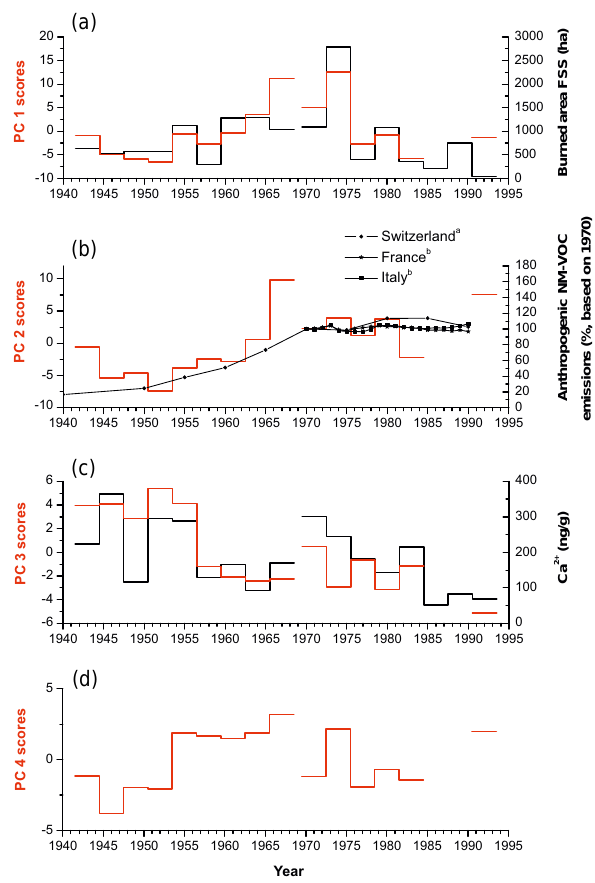
Figure 6. (a) Records of PC1 and FSS (burned area by fires in southern Switzerland), (b) PC2 and anthropogenic emissions of non-methane volatile organic compounds (NM-VOCs) in Switzer- land, France, and Italy from 1940 to 1990, (c) PC3 and his- toric record of Ca 2 + , (d) PC4. Data in (b) were extracted from BUWAL (1995) and EDGAR (2010) (black symbols: annual av- erages, red/black line: 3-year averages). Records of the PC1–PC4 are given as z scores (records normalized and scaled to a mean of 0 and a standard deviation of 1).